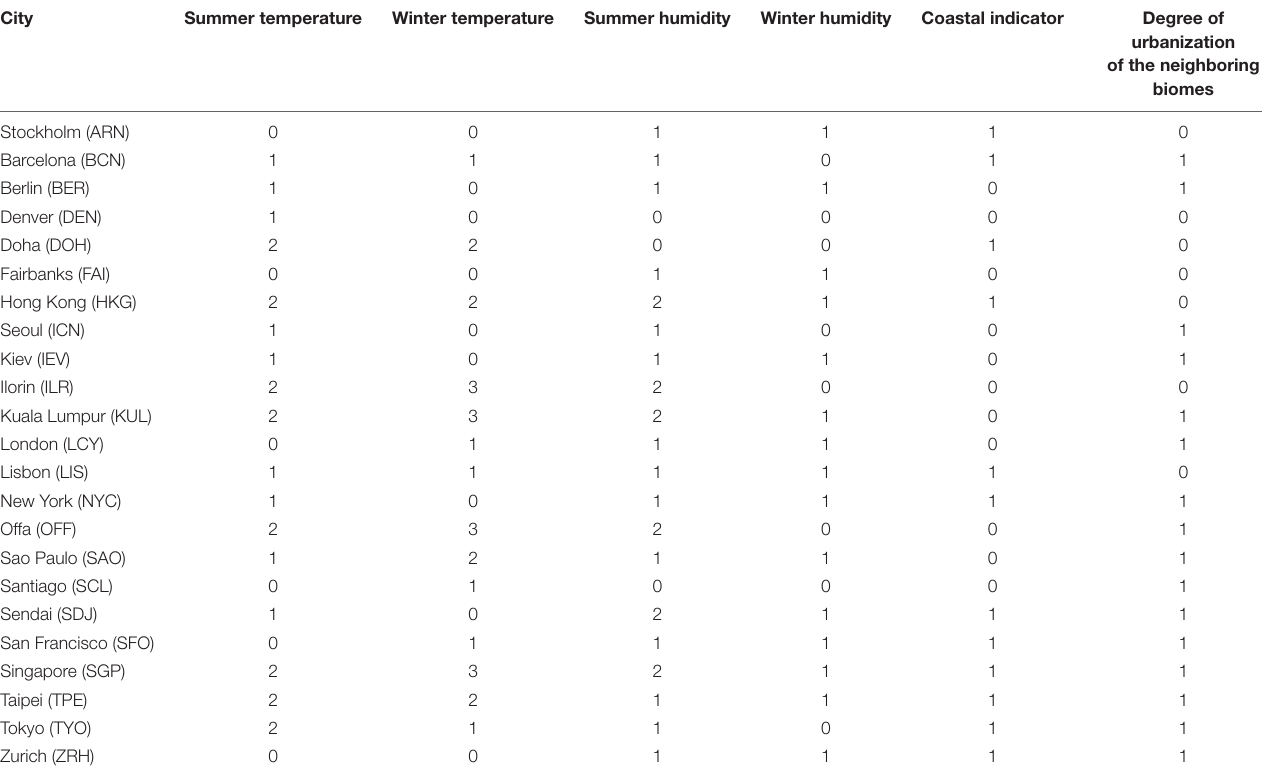
TABLE 2 | Details of the group assignment for each city in the main dataset.